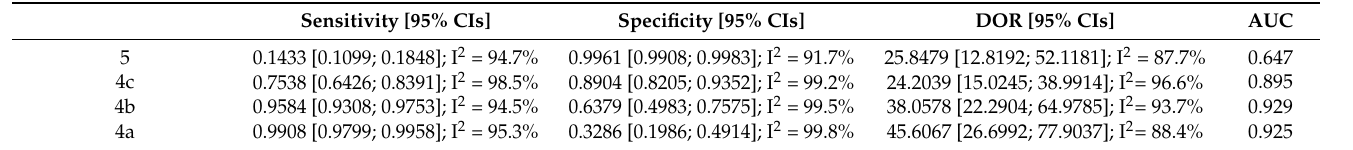
Table 5. Diagnostic efficacy and the ROC curves of Kwak-TIRADS